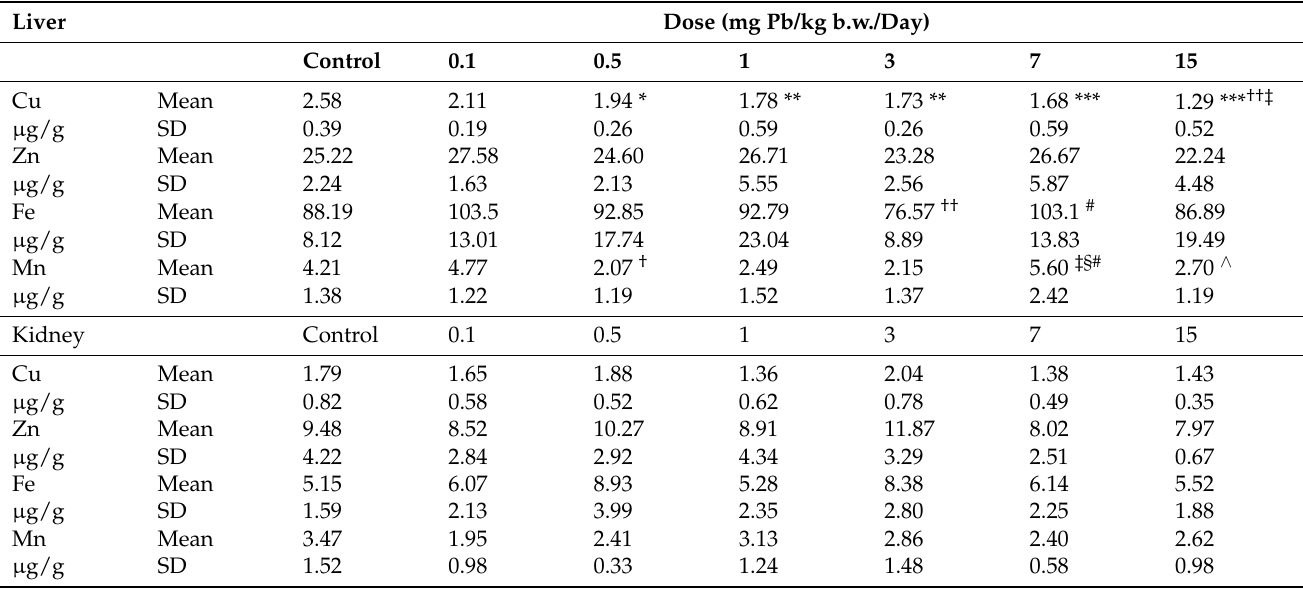
Table 2. Essential elements levels in liver and kidneys tissue of Wistar rats subacutely exposed to low levels of Pb.